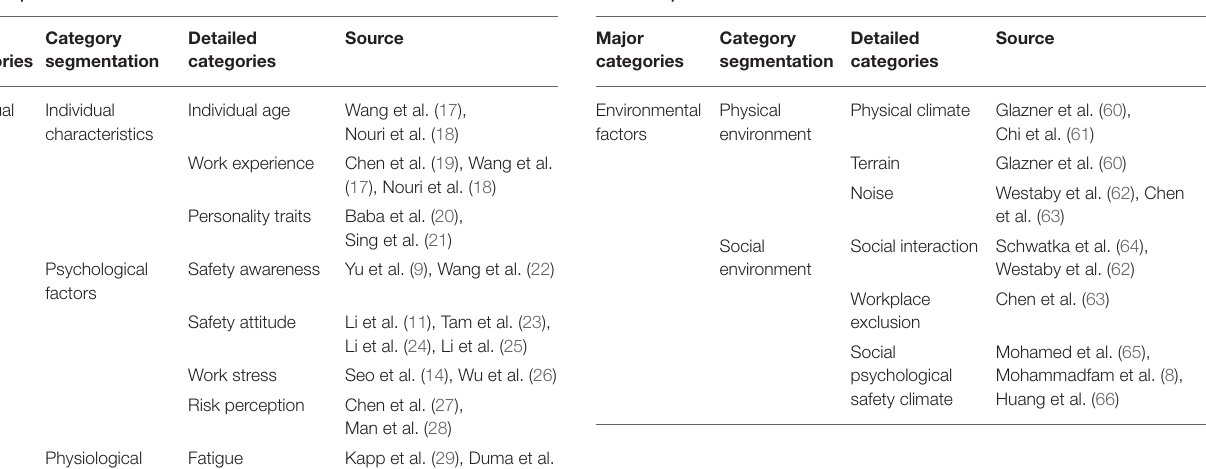
TABLE 5 | Environmental